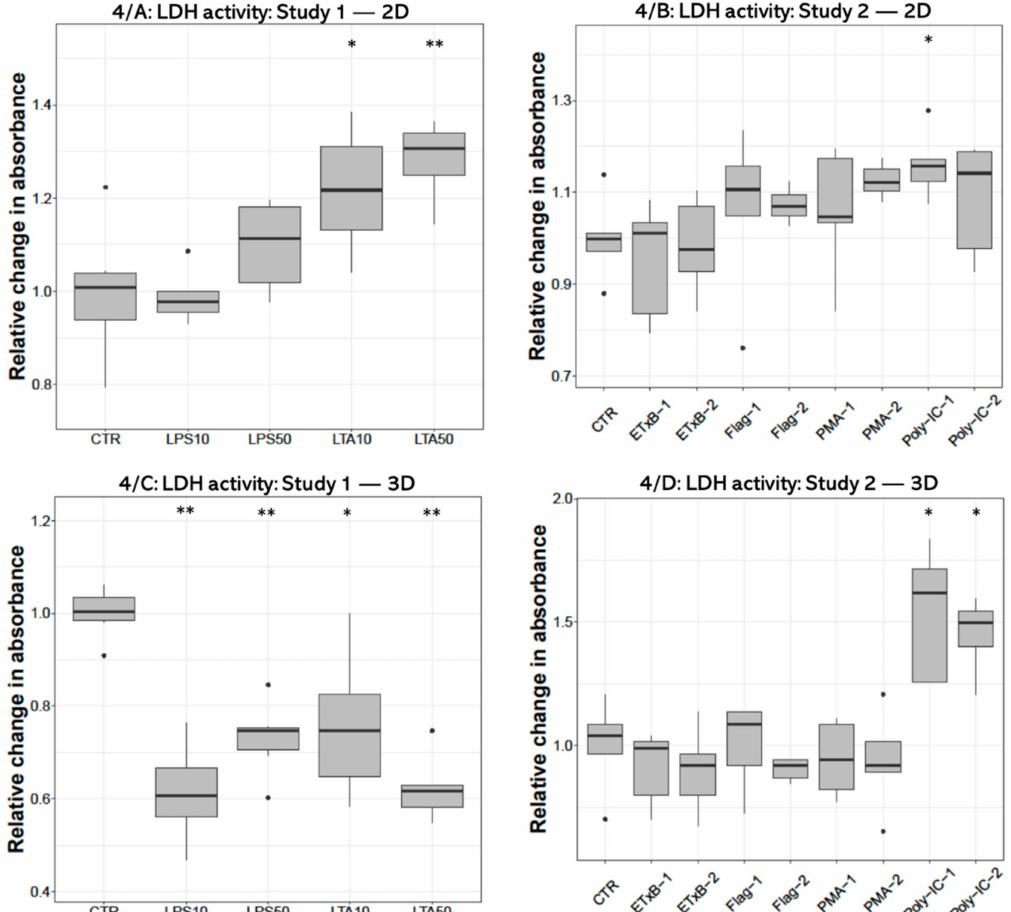
Figure 4. Boxplots showing the extracellular lactate dehydrogenase (LDH) activity of hepatocyte—non-parenchymal cells in 2D (Study 1: ( A ) and Study 2: ( B )) and 3D (Study 1: ( C ) and Study 2: ( D )) co-cultures as indicated by enzyme kinetic assay (n study 1 = 6/group, n study 2 = 5/group). Relative changes in absorbances were calculated by considering the mean value of control cultures as 1. The “CTR” refers to control cells that received none of the treatments. The treatments were: LPS10 and LPS50 = 10 and 50 µ g/mL lipopolysaccharide (LPS) from Escherichia coli , LTA10 and LTA50 = 10 and 50 µ g/mL lipoteichoic acid (LTA) from Staphylococcus aureus , ETxB-1 and -2 = 20 and 50 µ g/mL subunit B of heat-labile enterotoxin of Escherichia coli , Flag-1 and -2 = 100 and 250 ng/mL flagellin from Salmonella Typhimurium, PMA-1 and -2 = 100 and 1000 ng/mL phorbol myristate acetate (PMA), poly-IC-1 and -2= 50 and 100 µ g/mL polyinosinic polycytidylic acid (poly I:C). Asterisks over the boxes refer to significant differences compared to “CTR” cells within the same cell culture model and the same study. * p < 0.05, ** p <